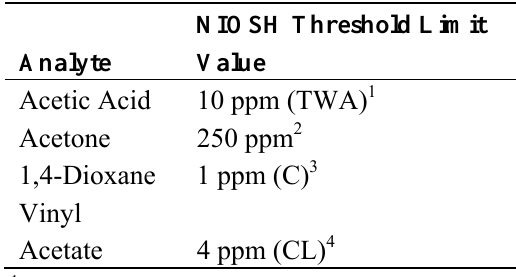
Table 1. Summary of relevant airborne exposure limits. The threshold limit value (TLV) for chemical substances is defined as a concentration in air, typically for inhalation or skin